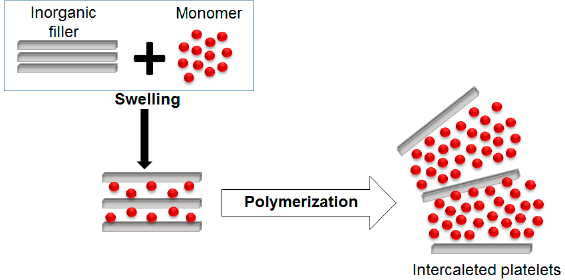
Figure 20. Schematic representation of the intercalation of monomers in-situ polymerization (Redraw and adapted figure from [93]).